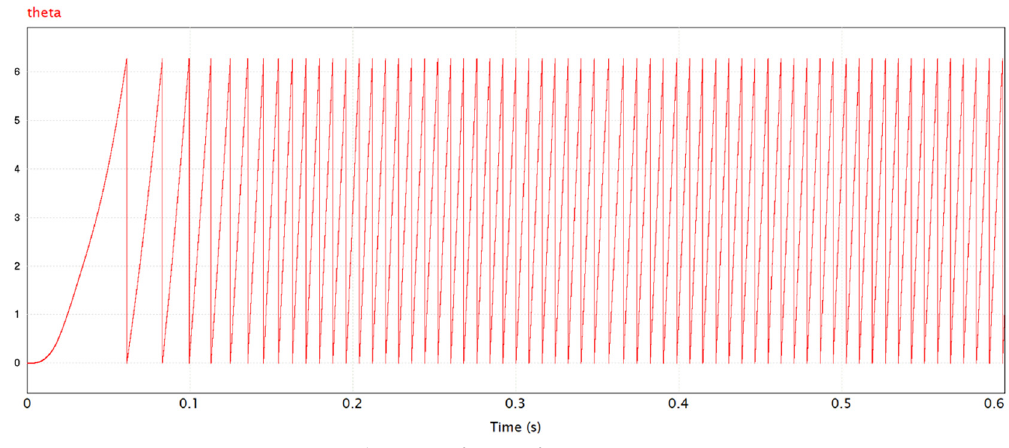
Figure 9. Configuration of experimental setup.